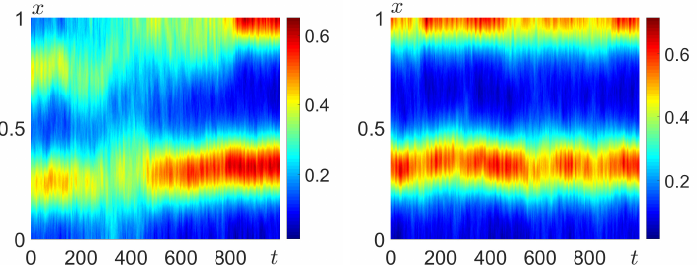
Figure 14. Unidirectional noise-induced transition 2 ↑→ 1.5 ↑ ( left ) and no transition from 1.5 ↑ ( right ) in Systems (1), (2) with a = d = e = 0.5, c = 1, D u = 5 × 10 − 4 , D v = 0.02, b = 1.2, ε =